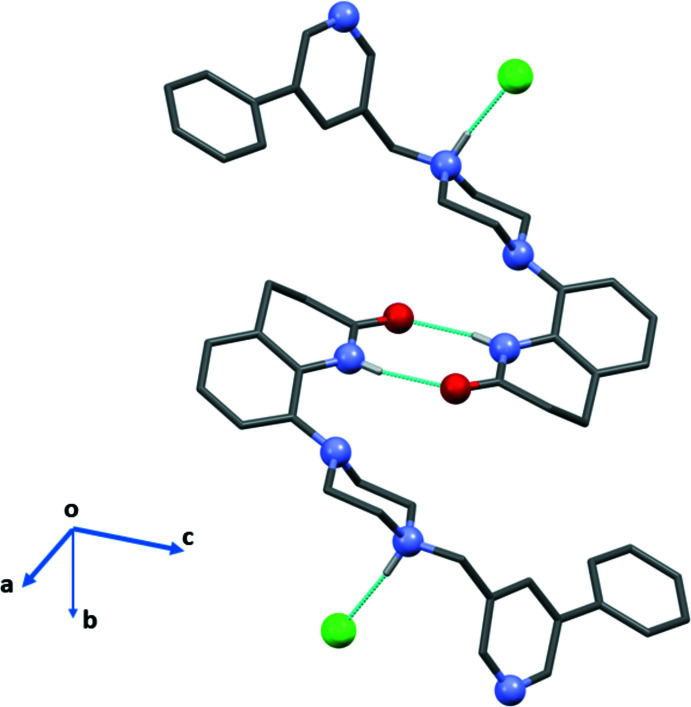
A view of the hydrogen bonded dimer formation in the crystal of salt I·HCl. Hydrogen bonds are shown as dashed lines (see Table 1 ▸).